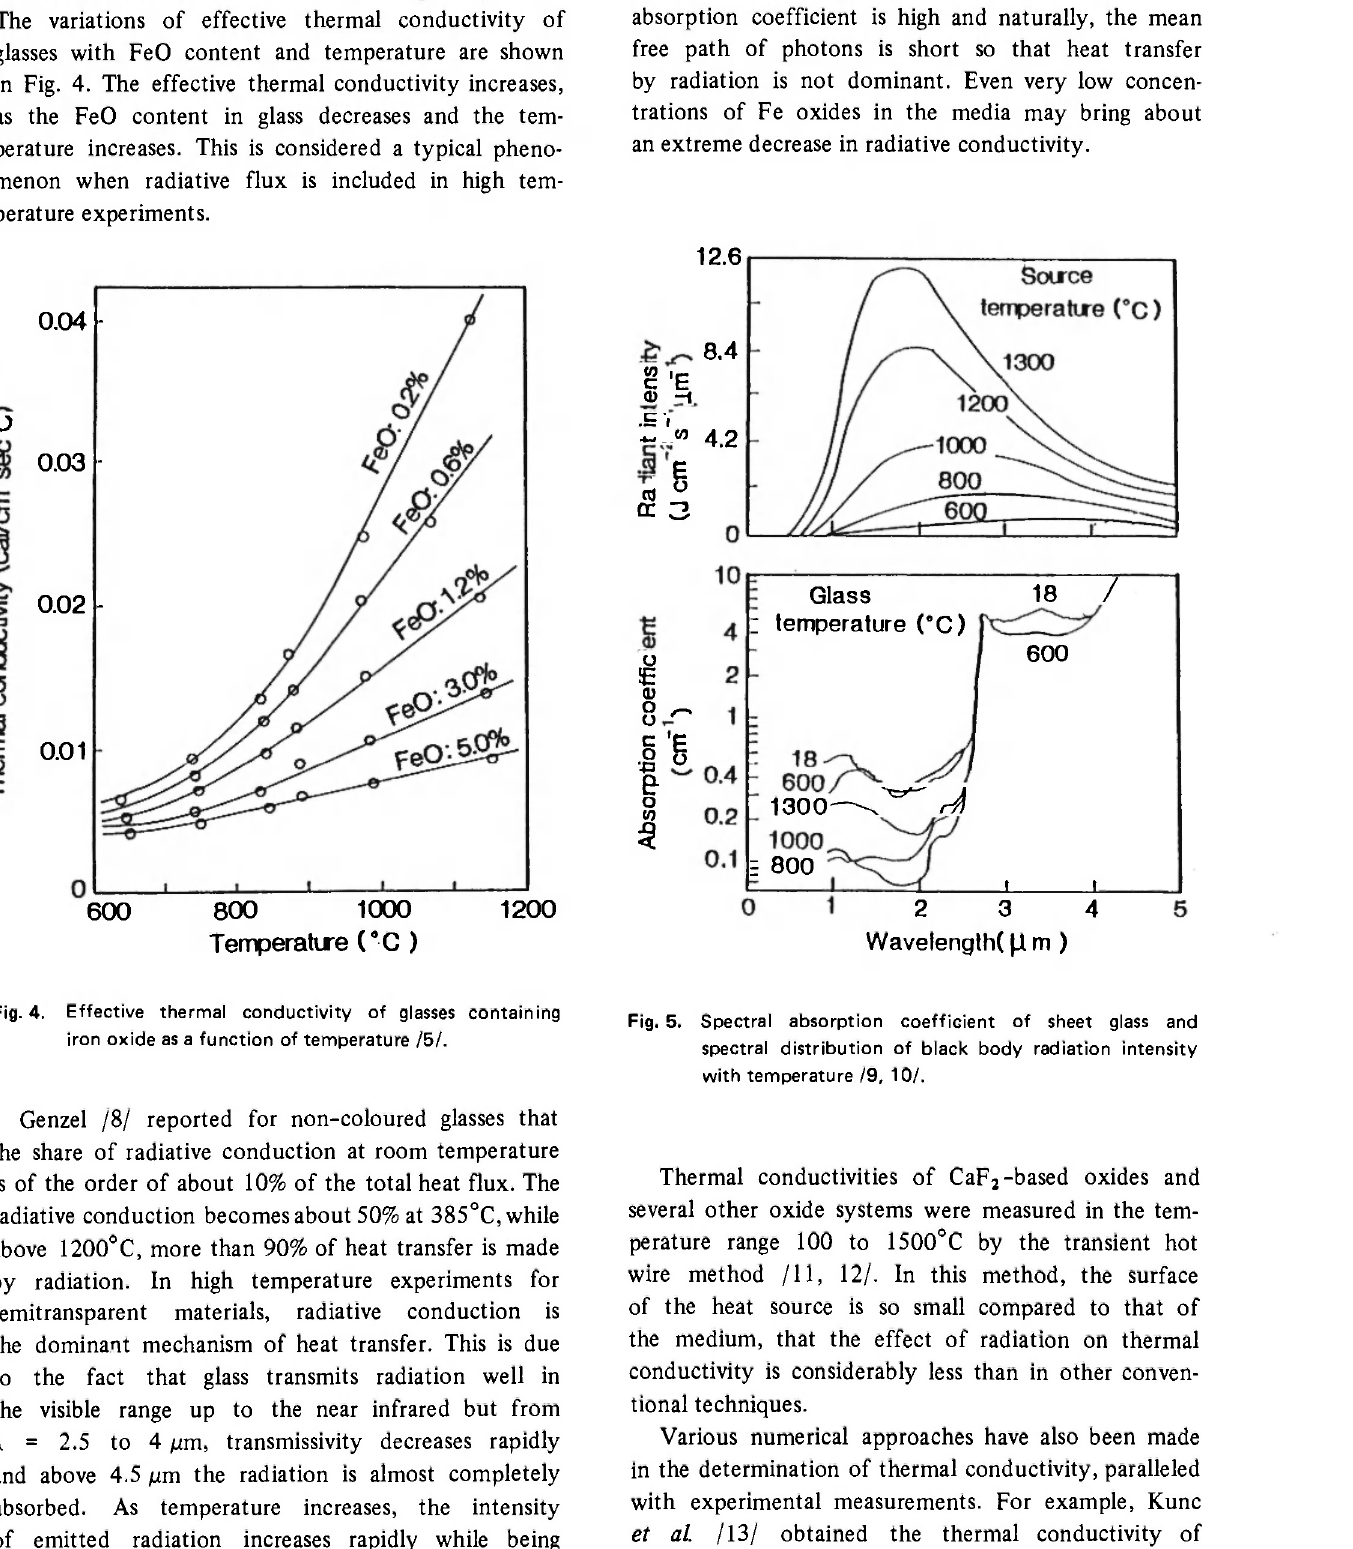
Fig. 4. Effective thermal conductivity of glasses containing iron oxide as a function of temperature /5/.